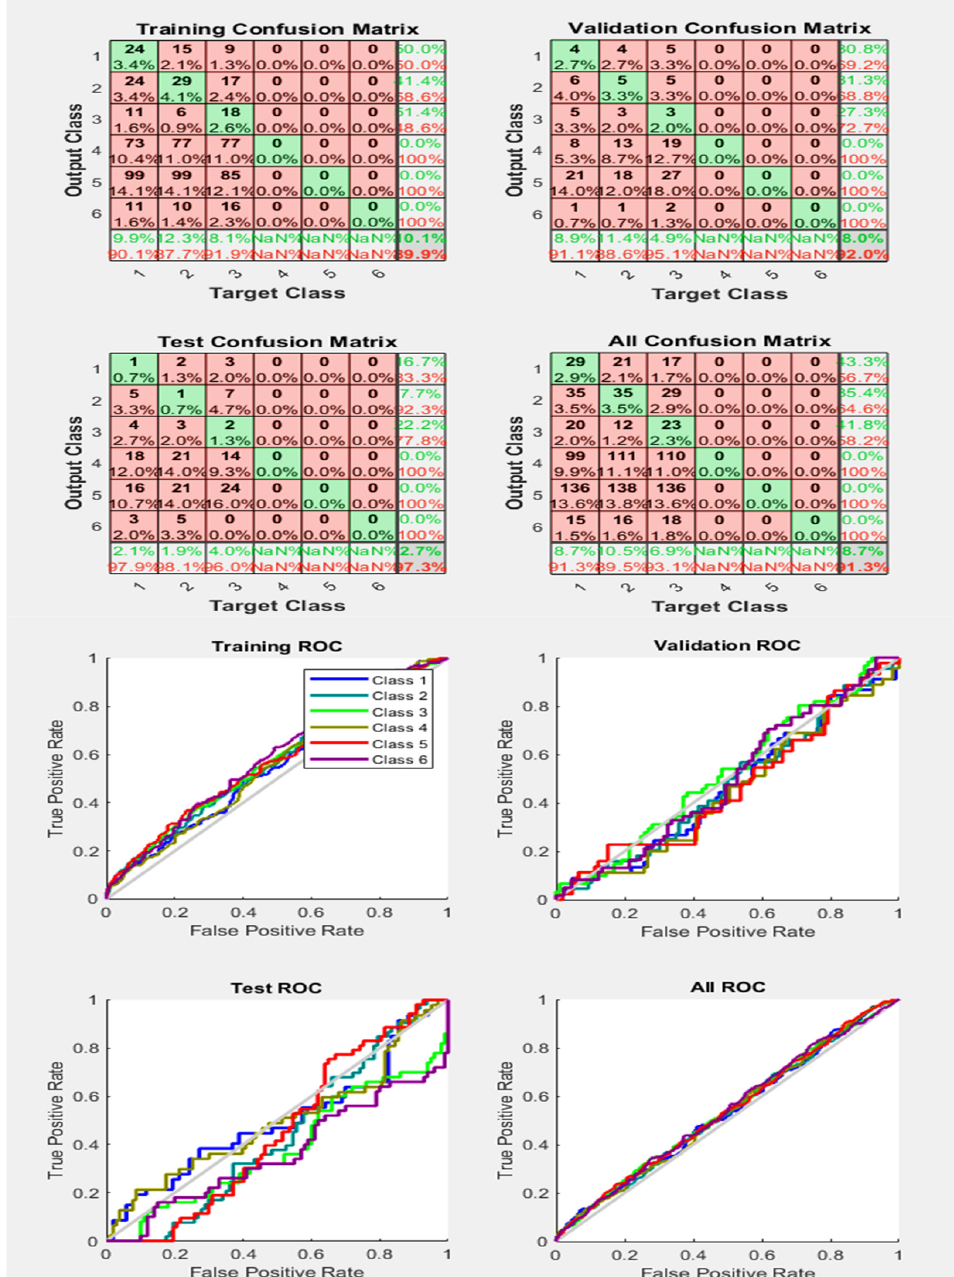
Figure 26. Neural Network Model ROC (Receiver Operating Characteristics) and Confusion Matrix for LM TrainFcn/Activation Function at level 9 (RMS) Features for Rotor Bar Fault with 91.3% Accuracy. Grey line shows diagonal of the ROC for indicating Class 1–6 lines are lying above or below or on it.